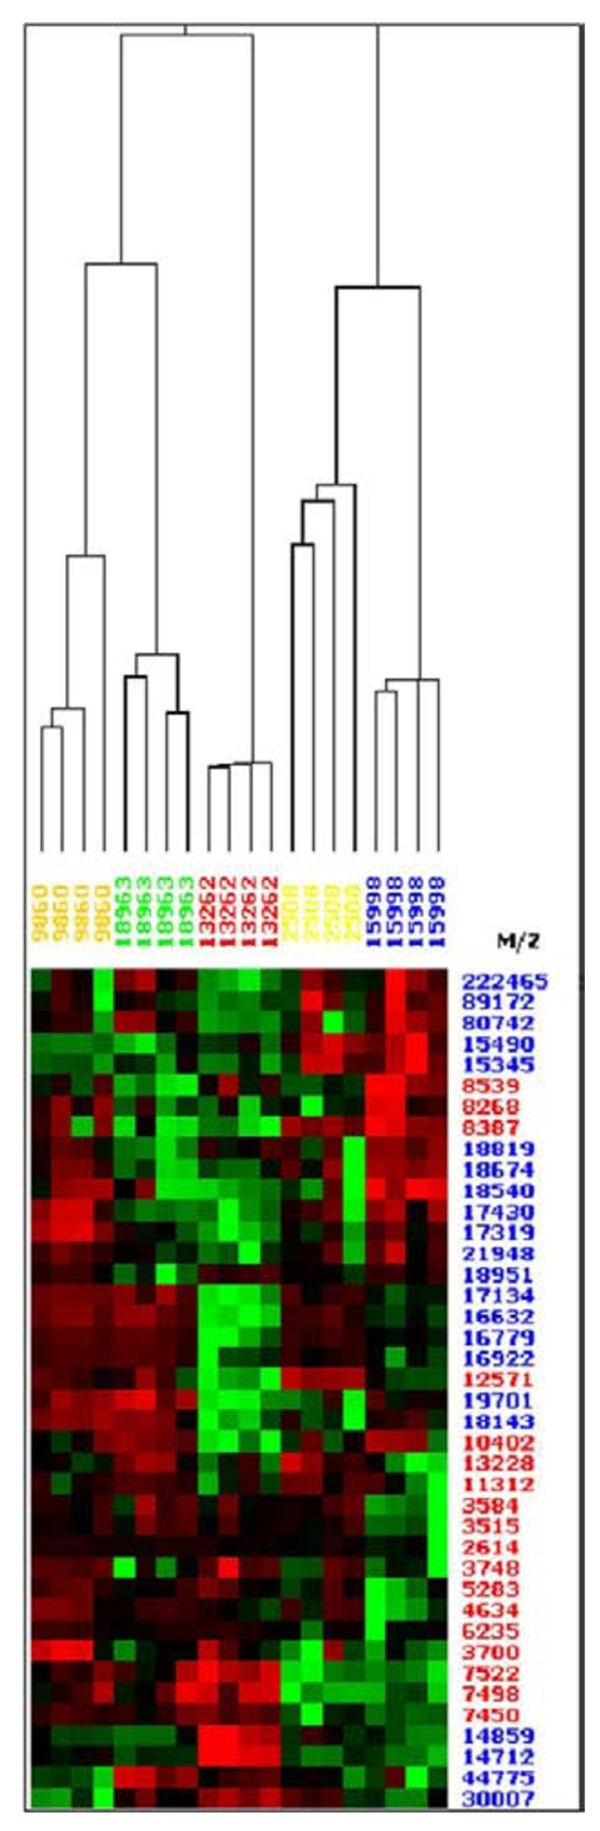
Proteomic comparison between abnormally pigmented strains and a wild-type reference strain of A. fumigatus on CM10 ProteinChips®. Hierarchical classification of metabolic extracts obtained in static culture for the five strains grown on modified Sabouraud medium at 37°C: white M IHEM 9860 (orange), reference WT strain IHEM 18963 (green), white M IHEM 13262 (red), white M IHEM 2508 (yellow) and brown M IHEM 15998 (blue). The proteins differentially expressed (p < 0.05) were listed on the right of the figure with laser intensities of 2500 nJ (in red) and of 4500 nJ (in blue).